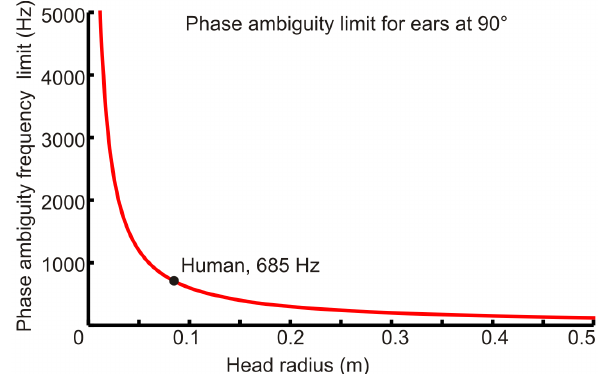
Figure 2. Phase ambiguity frequency limit for varying head size. This is the frequency at which interaural phase difference first reaches 180 u . This model is for ears at 90 u away from the midline. In this case the human phase ambiguity limit is 685 Hz (695 Hz for ears at 100 u ) for a head radius of 8.75 cm. As head size increases animals are restricted to using IPD as a non-ambiguous sound localization cue at lower frequencies. Animals with smaller heads have a greater range of frequencies in which IPD is a non-ambiguous